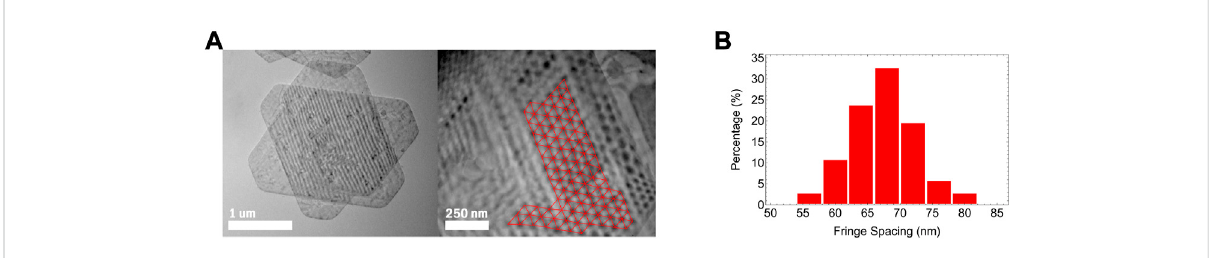
FIGURE 6 (A) TEM images of an Sb 2 Te 3 nanoplate with a visible moiré pattern. A nearest-neighbor grid is marked in red. (B) A histogram showing the distributionofsidelengthsinthisnearest-neighborgrid.Afringespacingof67.60±0.05 nmisdeterminedfromthisdata,andthusanestimatedtwist angle of 0.2074 ± 0.0003 °